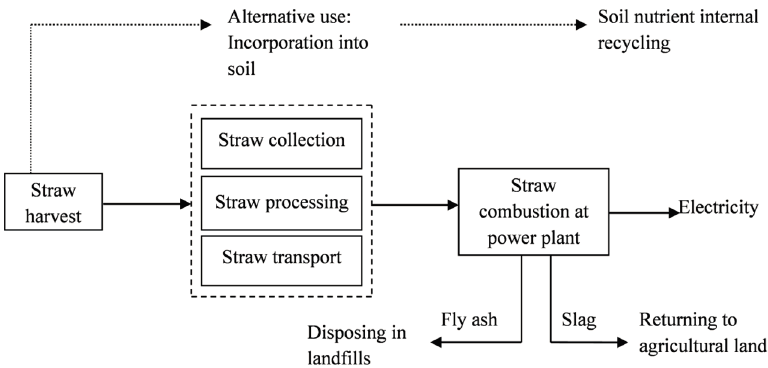
Figure 4. Lifecycle system of biomass power plant.